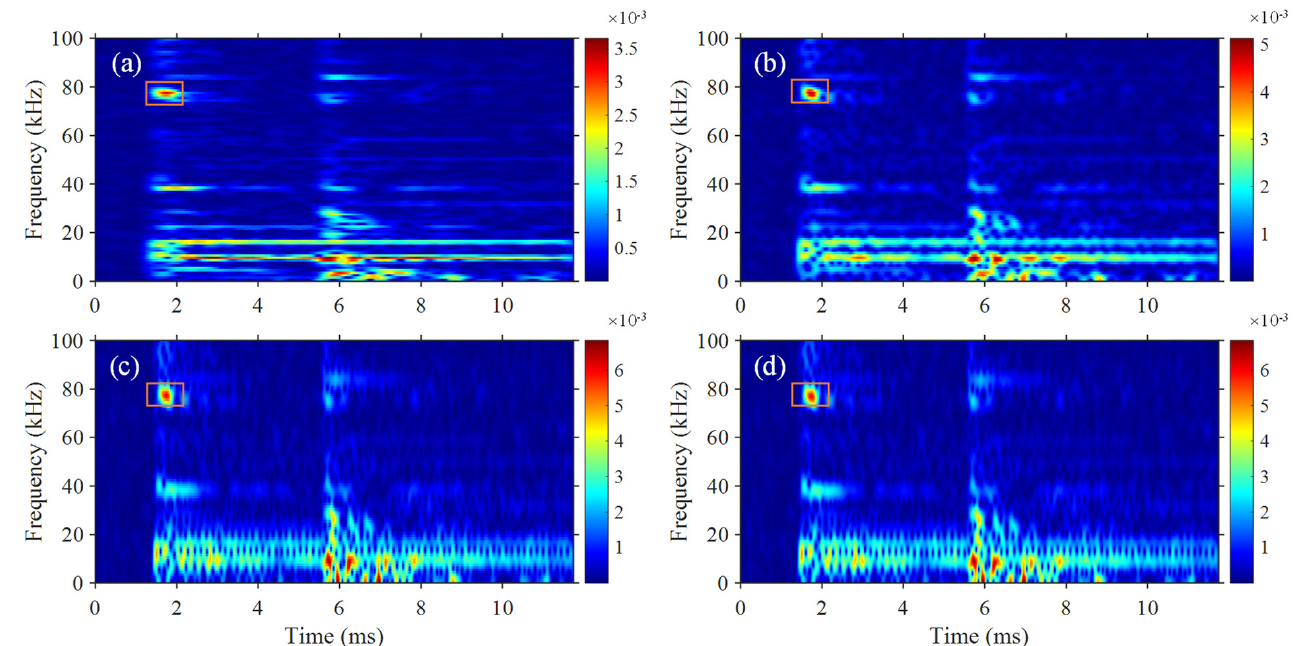
Figure 18. The time–frequency spectra obtained by STFT, the drawing frequency resolutions, and Hamming window widths were ( a ) 1 kHz and 1 ms; ( b ) 1 kHz and 0.5 ms; ( c ) 1 kHz and 0.25 ms; ( d ) 0.25 kHz and 0.25 ms, respectively